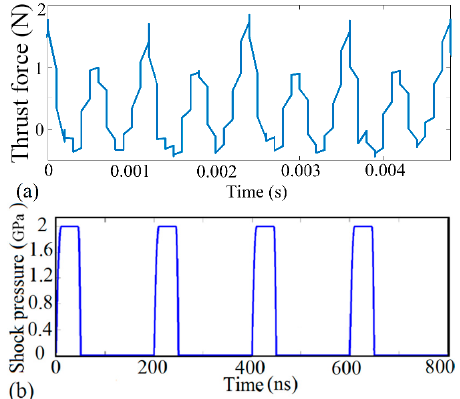
Figure 5. ( a ) Measured thrust force in experiment; ( b ) loading condition of shock wave in simulation.